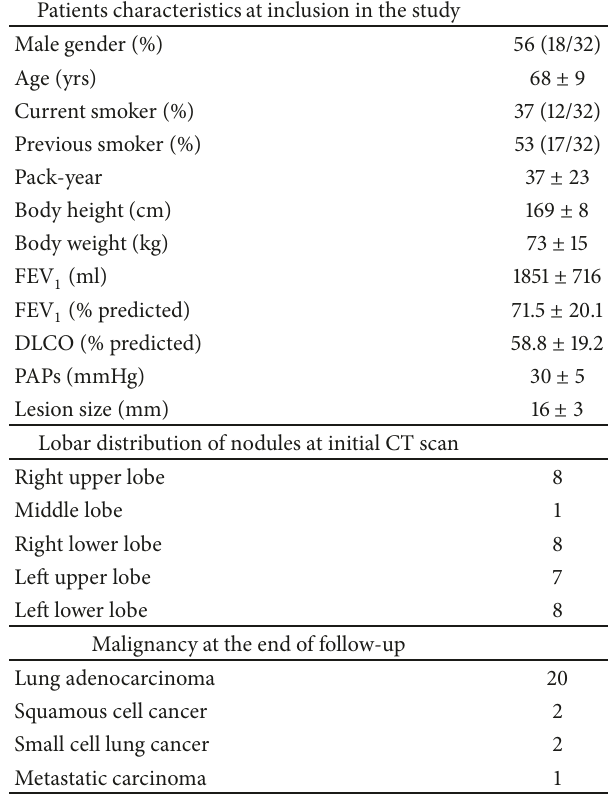
Table 1: Patients